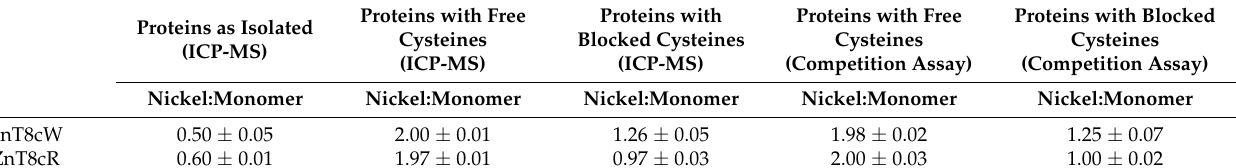
Table 5. Metal stoichiometries of ZnT8c variants from Ni(II) binding data.